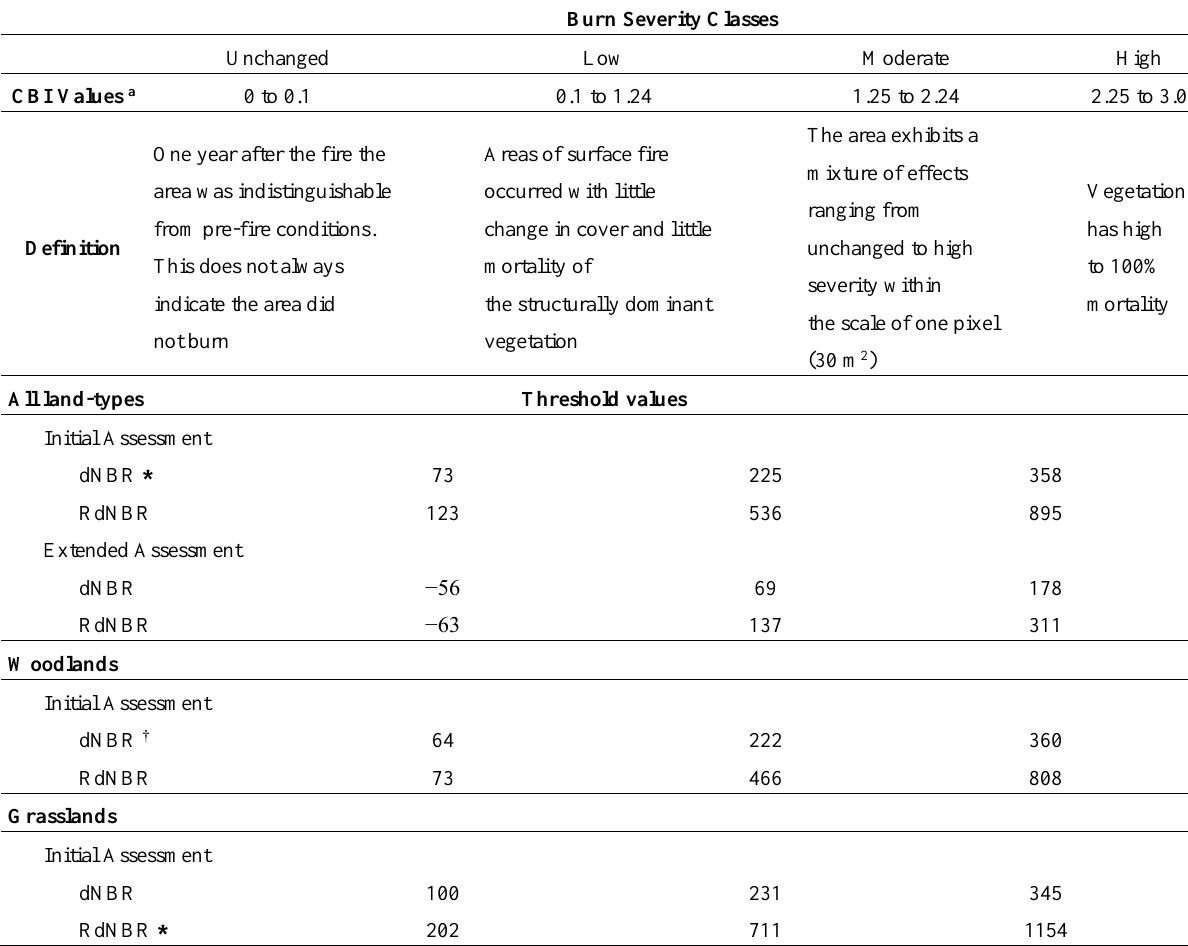
Table 4. Burn severity classes and their corresponding CBI values, definitions, and threshold values. CBI values and definitions follow Miller and Thode [42] and were deemed appropriate for the study area. Threshold value determinations were based on regression models in Table 3.